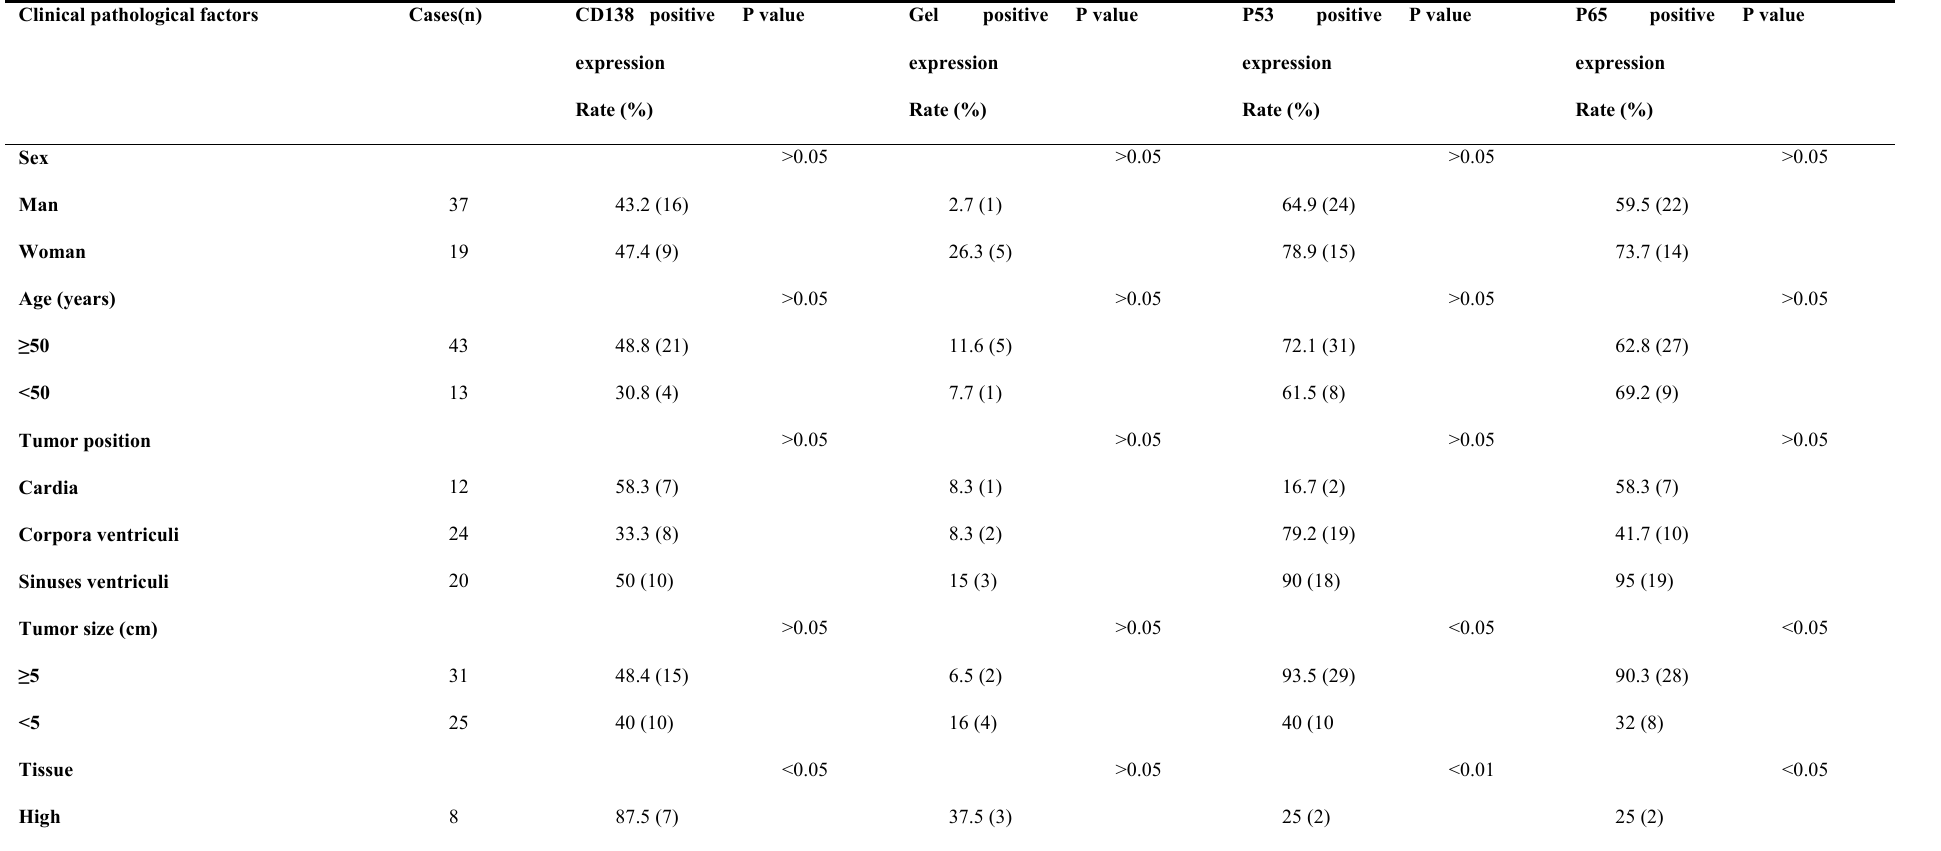
Table 3. Univariate analysis of relationship of CD138, Gelsolin, P53 and P65 expression with clinical pathological factors in patients with gastric